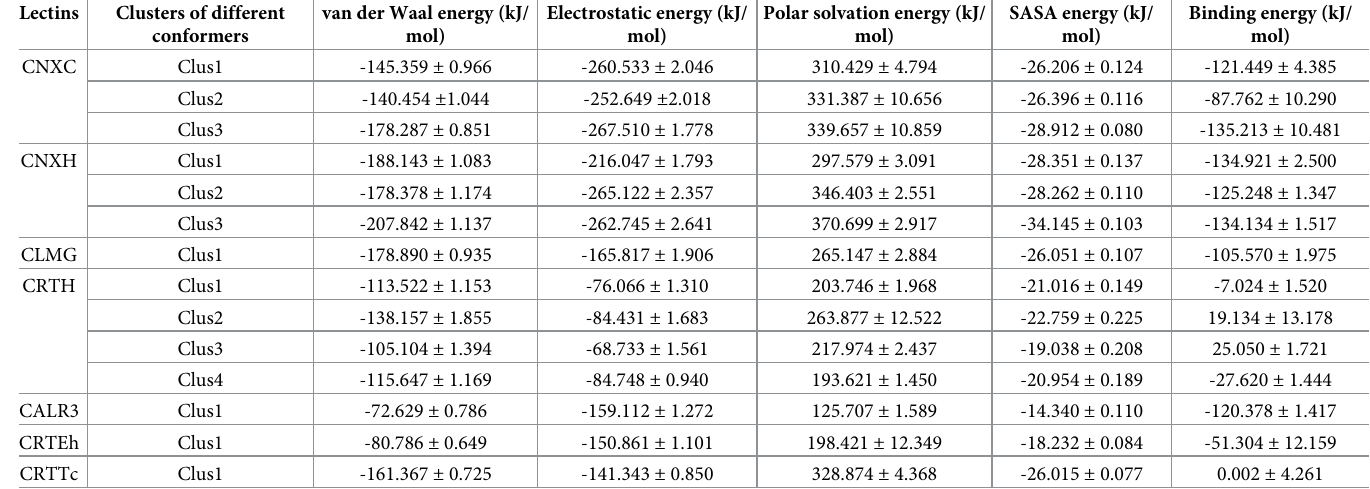
Table 4. mmPBSA calculations of various components of non-covalent binding energies for an ensemble of conformations in calnexin, calreticulin and their homo- logues bound to monoglucosylated-N-glycan. Lectins Clusters of different